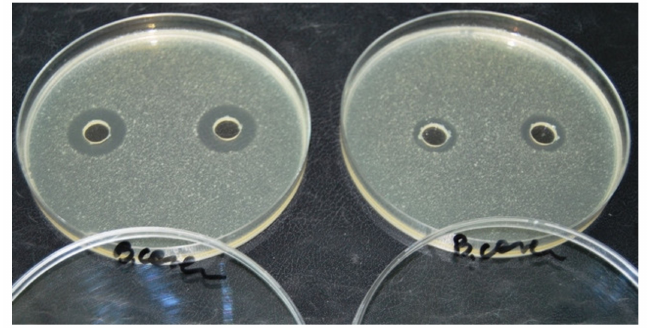
Figure 6. The presence of growth inhibition zones on B. cereus ATCC 11778